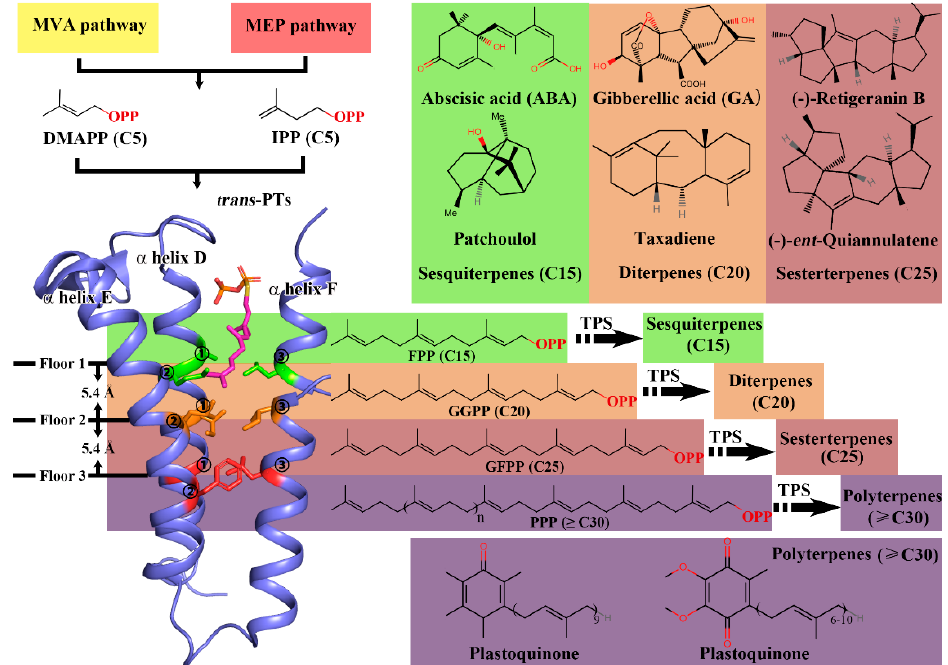
Figure 1. The “three floors” model and scheme of terpenoid biosynthetic pathway. The “three floors” model is illustrated using AtGGPPS11. For clarity, a substrate FPP (magenta sticks) is modeled into the structure using 3WJN as the reference model. The side-chains of residues from the “floors” are shown with sticks and colored in green (“first floor”), orange (“second floor”), and red (“third floor”). Dimethylallyl pyrophosphate (DMAPP) and isopentenyl pyrophosphate (IPP) from MVA/MEP pathways are used as substrates by trans- PTs to generate polyprenyl pyrophosphates with different chain lengths which are determined by the “three floors” model. These products from trans- PTs are the precursors of terpene synthases (TPSs) and can be further utilized to generate various terpenoids including sesquiterpenes (C15), diterpenes (C20), sesterterpenes (C25), and polyterpenes ( ≥ C30).